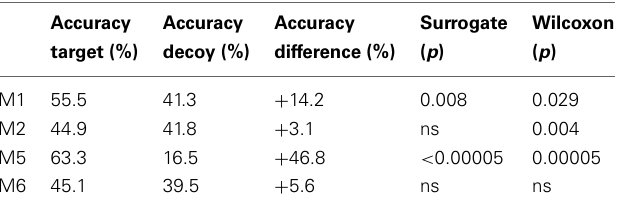
Table 1 | Percent accuracy and statistical significance for target vs. decoy ratings listed by medium.